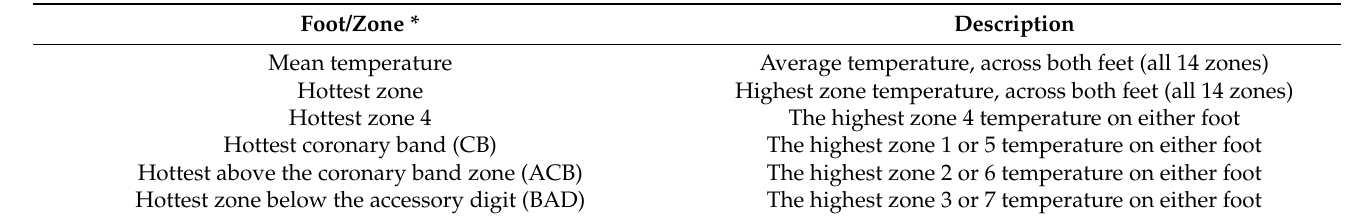
Table 1. Definitions of the infrared thermography estimates utilised for analysis adopted from [24].